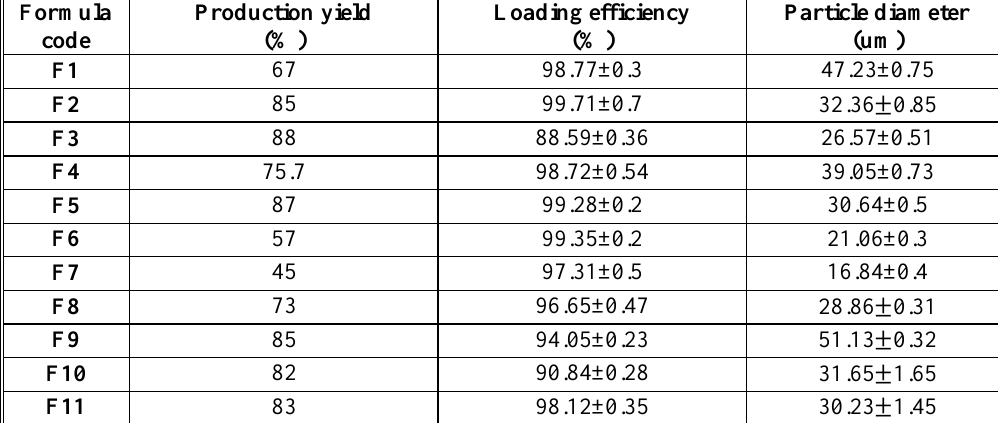
Table 2. Characterization of acyclovir microsponges